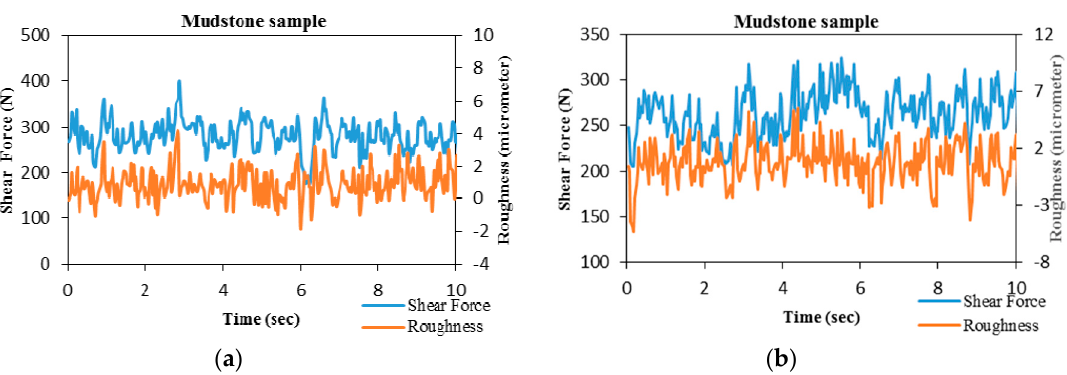
Figure 24. Variation of the shear force and the surface roughness during the scratch test of the mudstone sample: ( a ) d = 0.175 mm; ( b ) d = 0.185 mm.